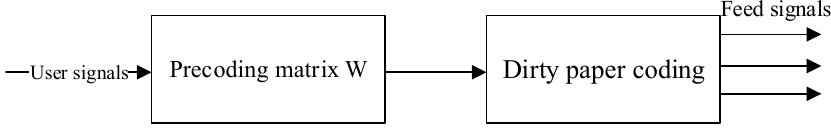
Figure 3. Application flow chart of dirty paper regularized zero-forcing precoding.